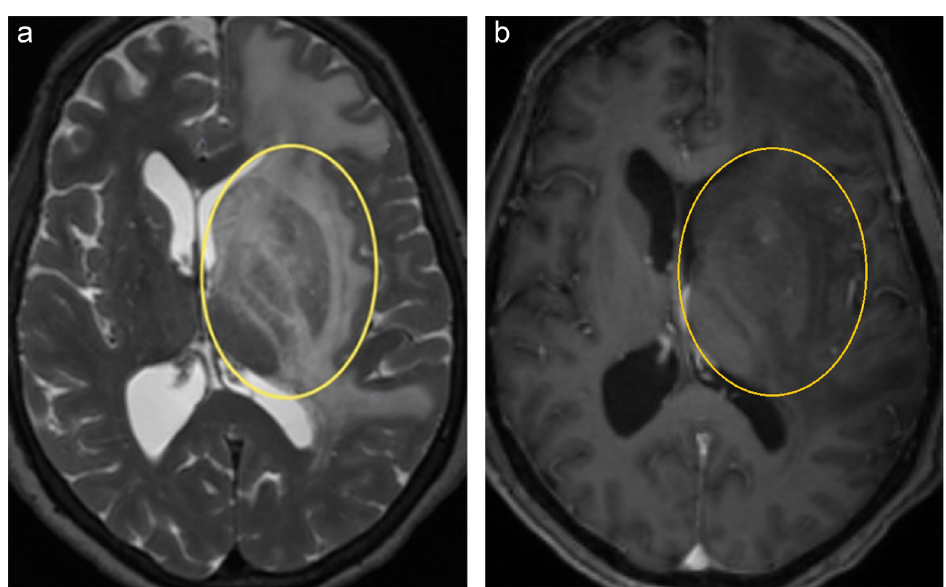
Fig 8. Transaxial slices from patient E: (a) T2 image with ROI (yellow), (b) corresponding T1 slice.